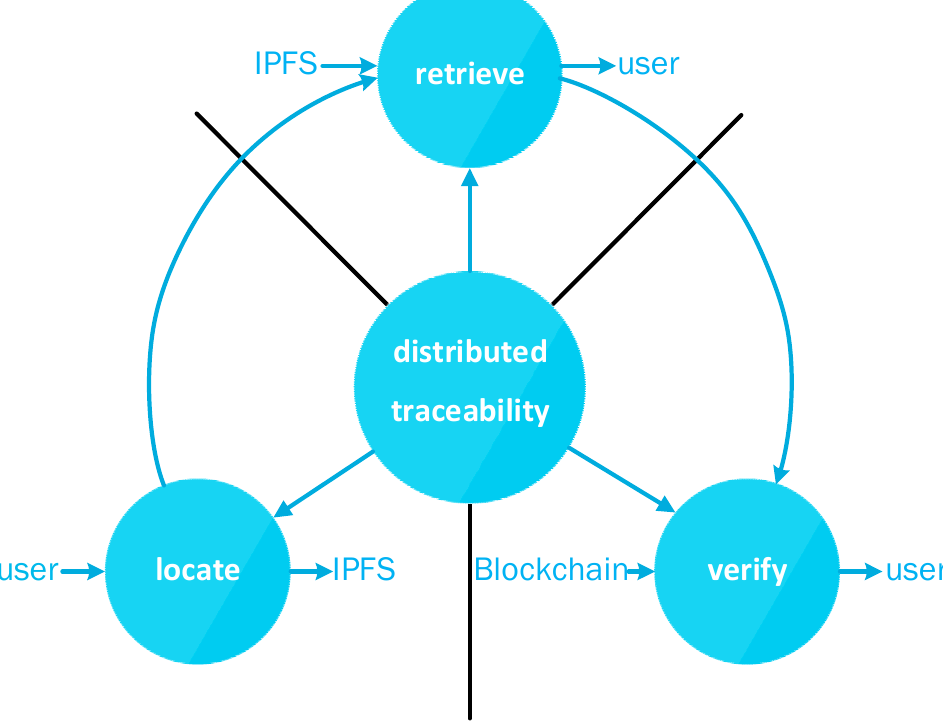
Figure 1. This paper subdivides the distributed traceability process into three stages: locating, retrieving, and verifying.